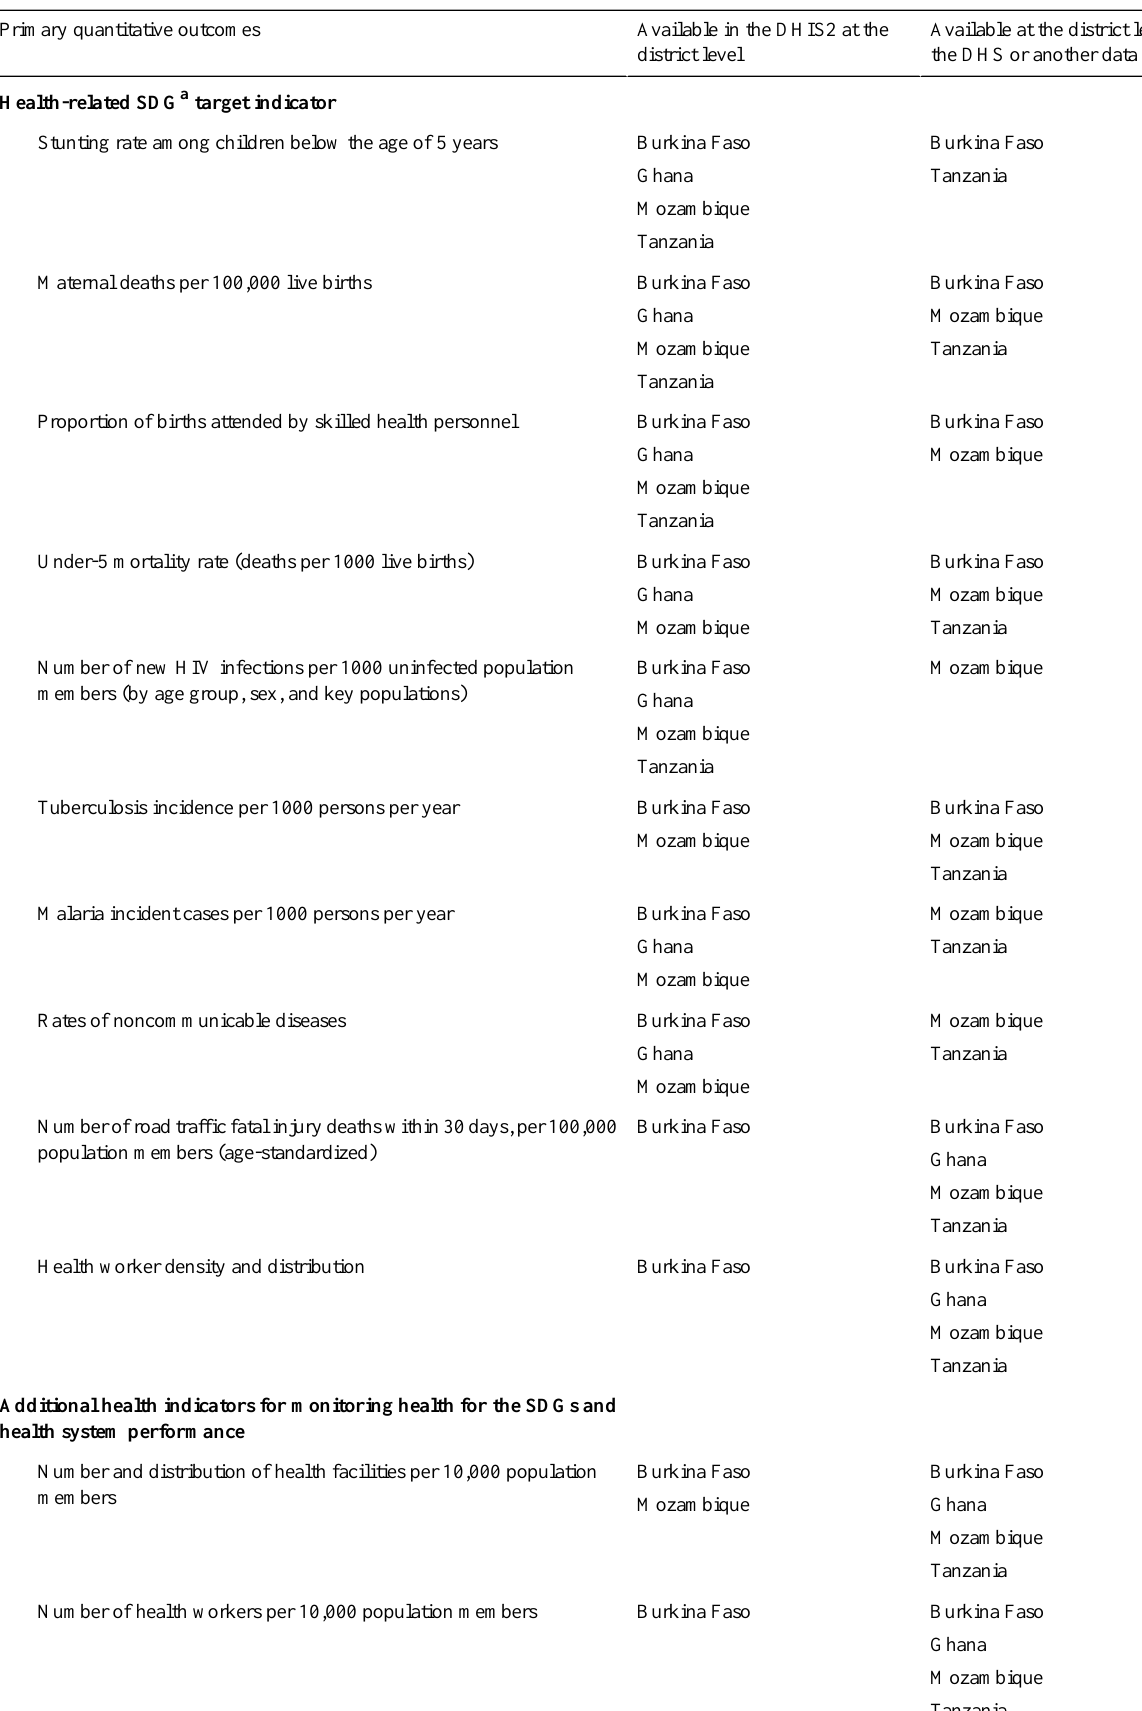
Table 1. Primary quantitative outcomes and data availability from the District Health Information System 2 (DHIS2), the Demographic and Health Survey (DHS), and other national-level